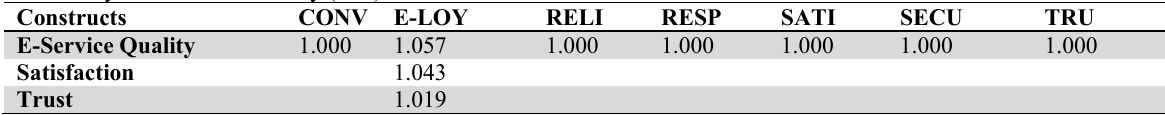
Collinearity and Multicollinearity (VIF)